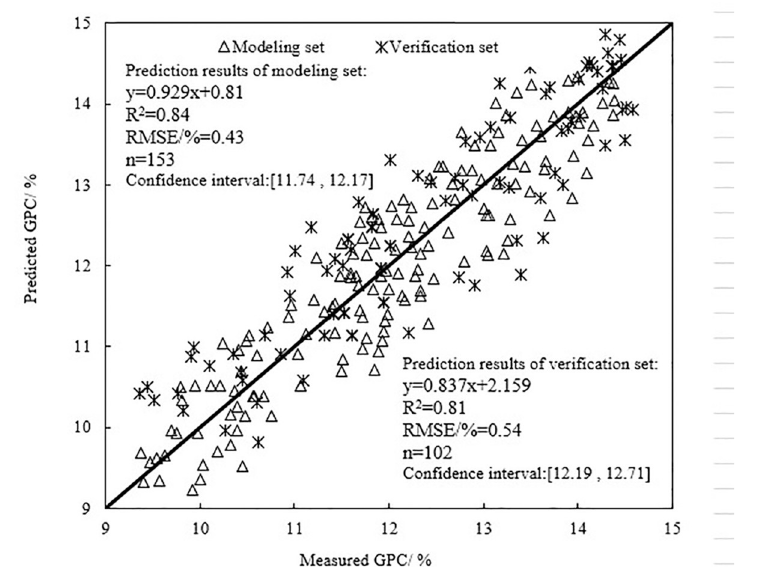
Fig 2. Evaluation of GPC model based on PLS